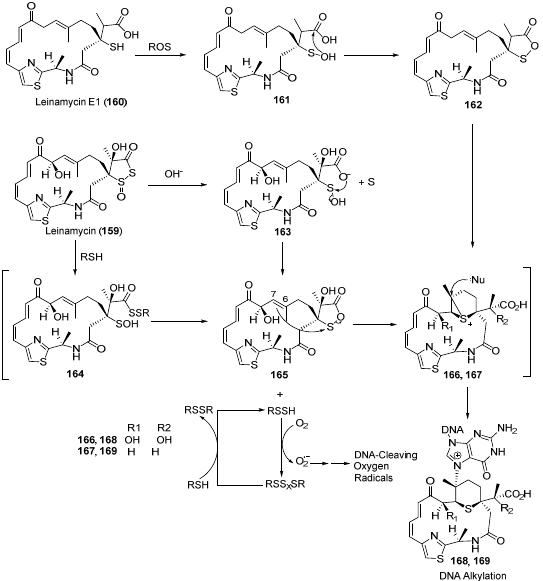
Figure 21. Proposed mechanisms of DNA alkylating by leinamycin and leinamycin E1 .